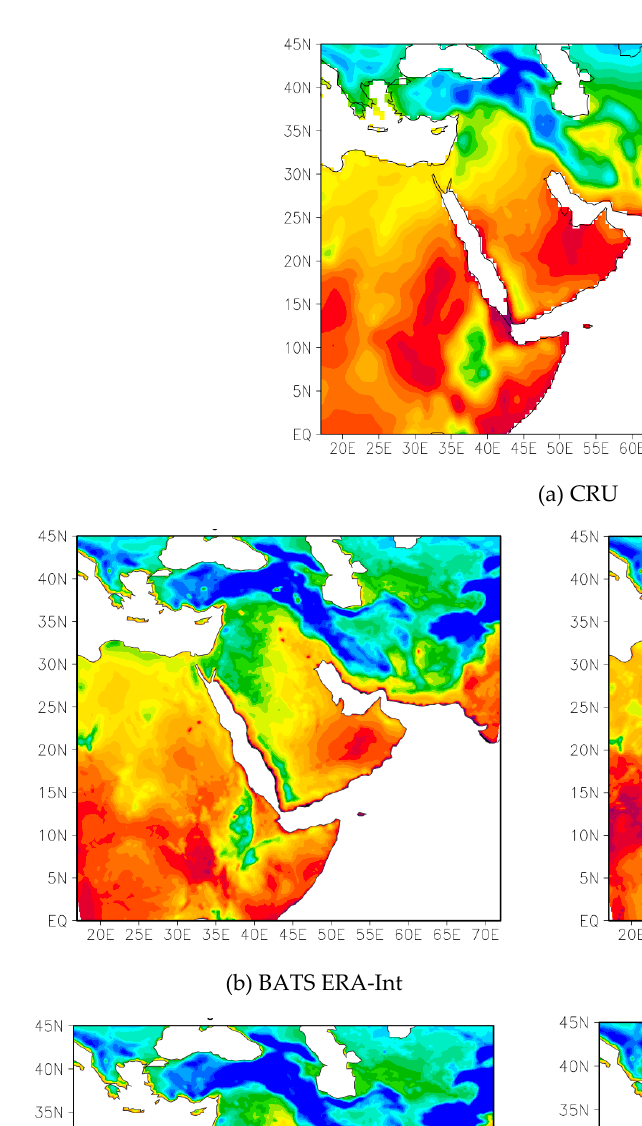
Figure 1. Spatial distribution of maximum temperature (°C) for ( a ) CRU, ( b ) ERA – Int BATS, ( c ) ERA – Int CLM, ( d ) ECHAM6 BATS, ( e ) ECHAM6 CLM, ( f ) GFDL BATS, ( g ) GFDL CLM, ( h ) HadGEM BATS, and ( i ) HadGEM CLM averaged over the period 1980 – 2005.